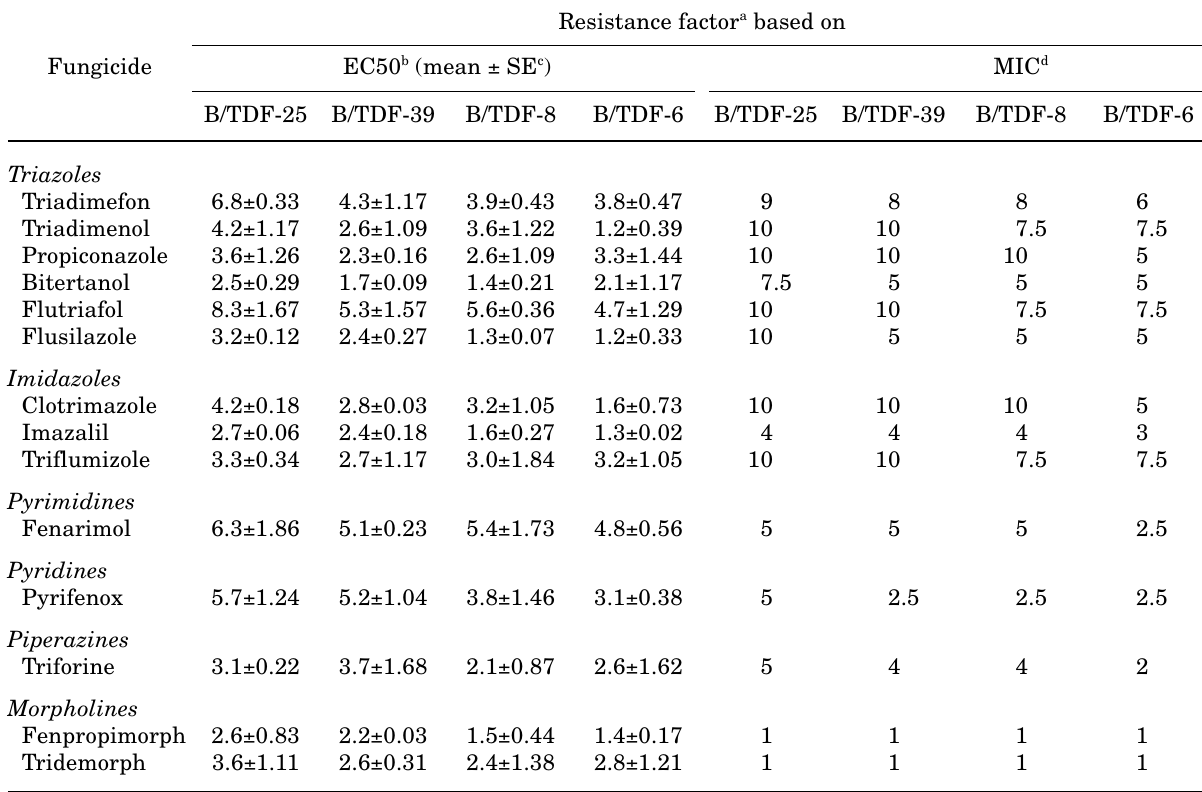
Table 4. Reduced sensitivity to sterol biosynthesis inhibitors of four representative triadimefon-resistant mutant strains (B/TDF-25, B/TDF-39, B/TDF-8, B/TDF-6) of Botrytis cinerea .